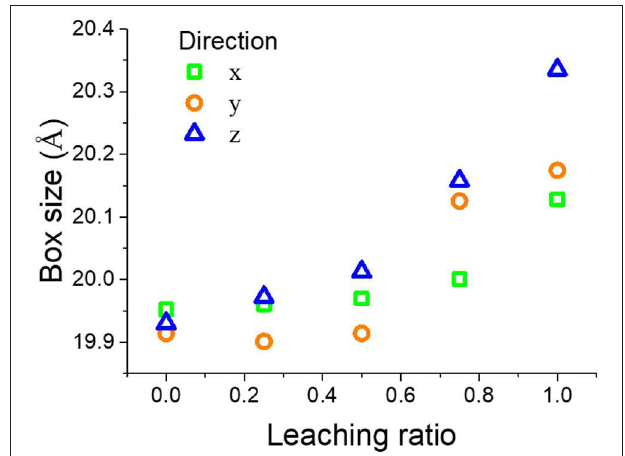
FIGURE 2 | Variation of N-A-S-H gel size with leaching ratio.